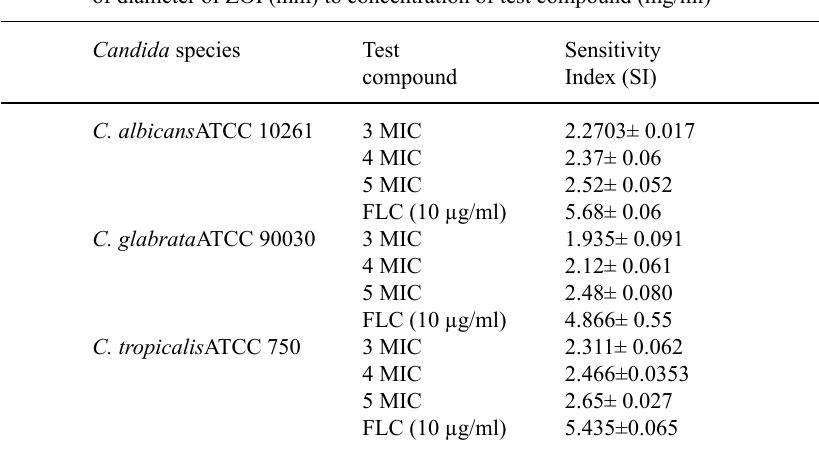
table 2. In vitro Candida sensitivity to geraniol as determined by disc diffusion assay. Each strain was tested in triplicate. Sensitivity Index (SI) is expressed as mean ± SD and was calculated as the ratio of diameter of ZOI (mm) to concentration of test compound (mg/ml) Candida species